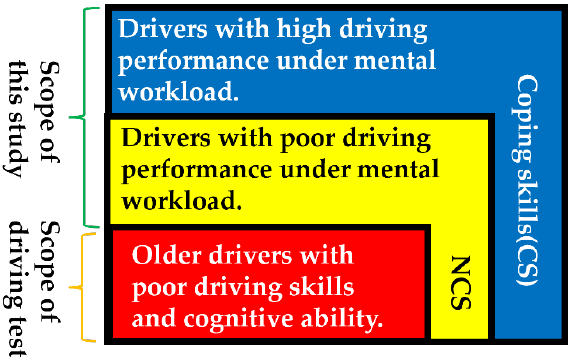
Figure 1. Definition of elderly drivers with coping skills (CS) and without coping skills (NCS) [8].